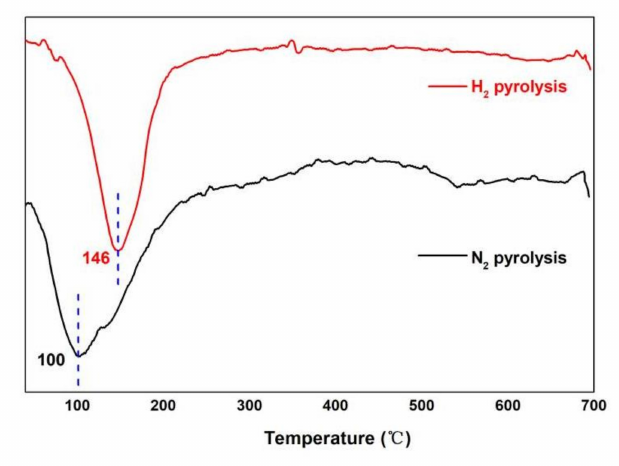
Figure 4. DTG of pyrolysis oil under different